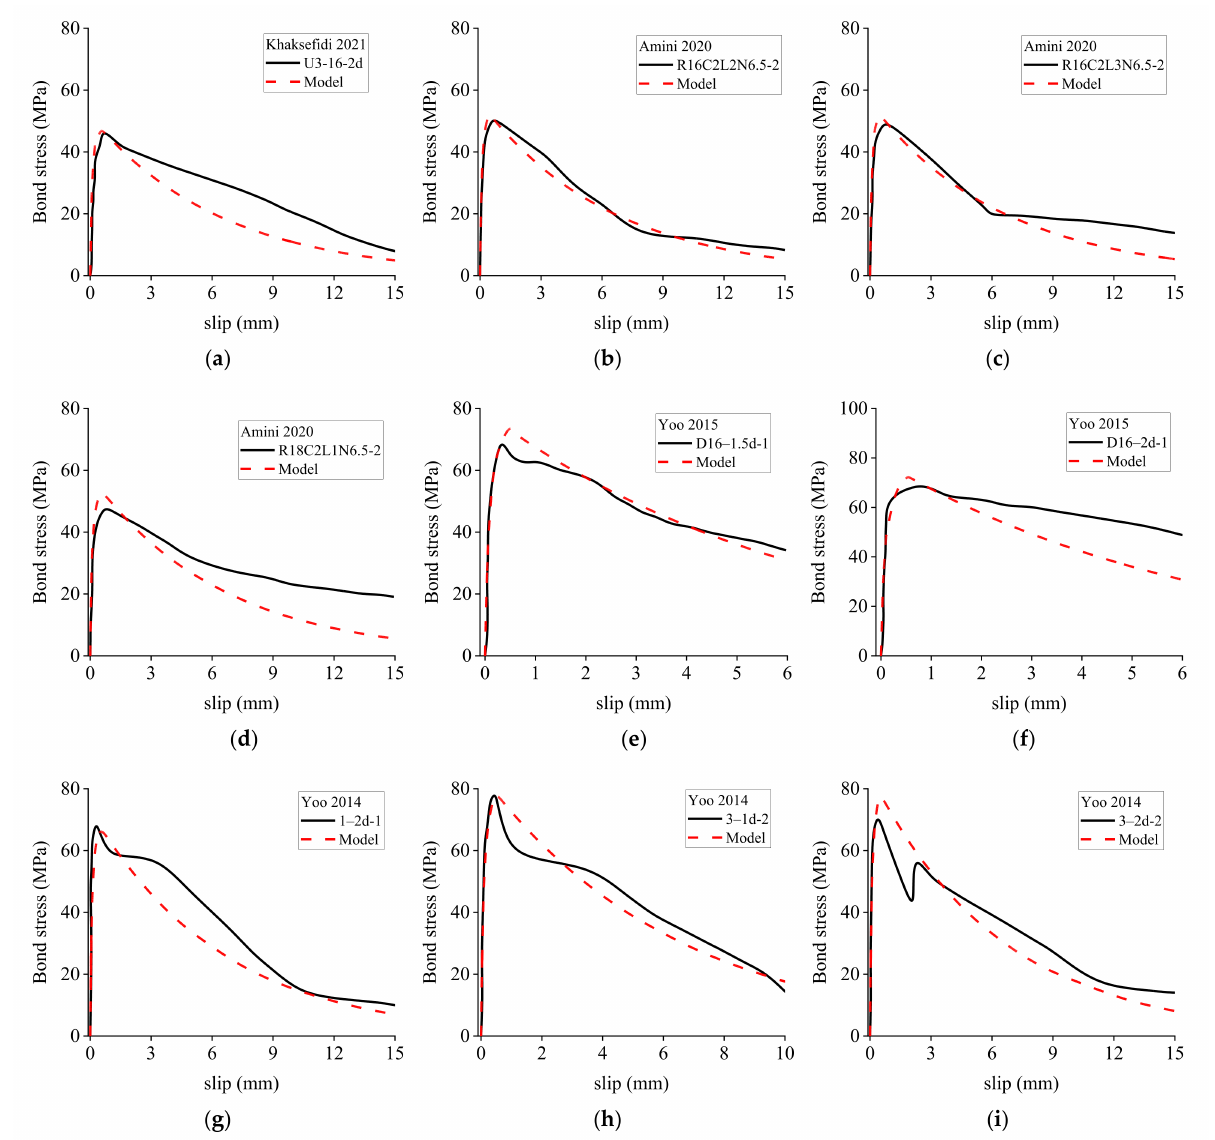
Figure 18. Comparison of the model predictions with the tested bond-slip curves by other researchers: ( a ) U3-16-2d; ( b ) R16C2L2N6.5-2; ( c ) R16C2L3N6.5-2; ( d ) R18C2L1N6.5-2; ( e ) D16-1.5d-1; ( f ) D16-2d-1; ( g ) 1-2d-1; ( h ) 3-1d-2; ( i )